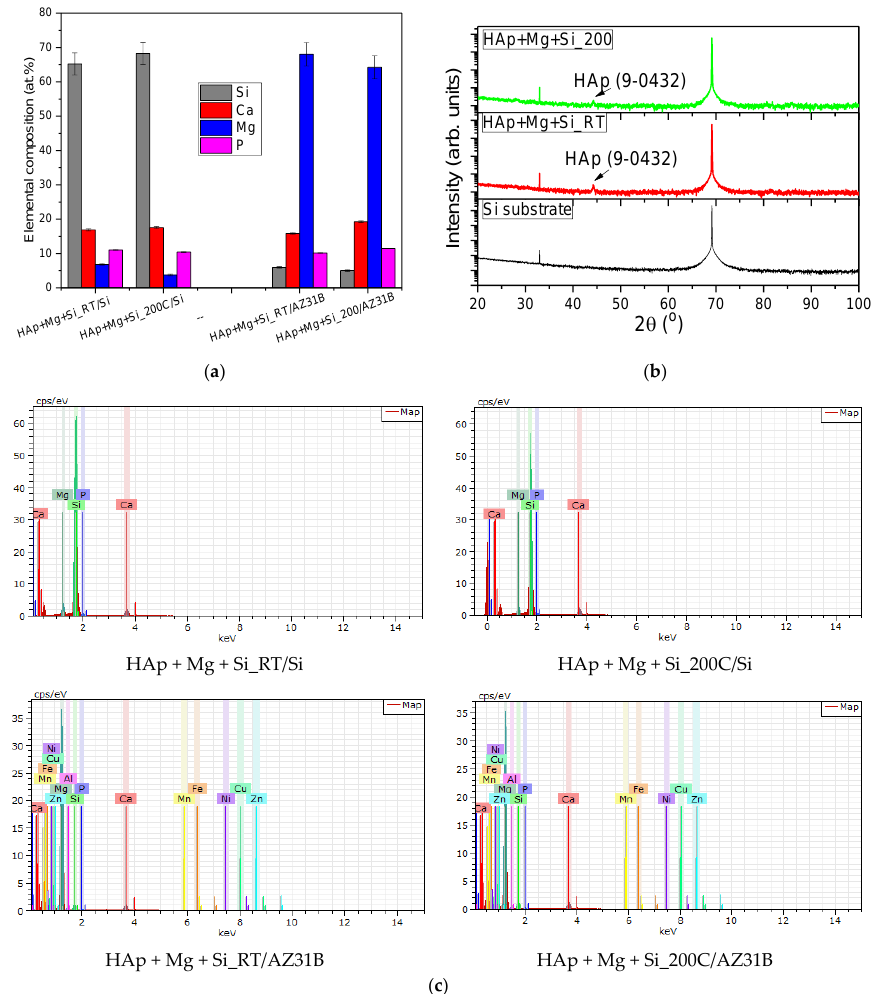
Figure 1. ( a ) Elemental composition; ( b ) GIXRD diffraction patterns of the coatings; and ( c ) EDS spectrum of each coating.